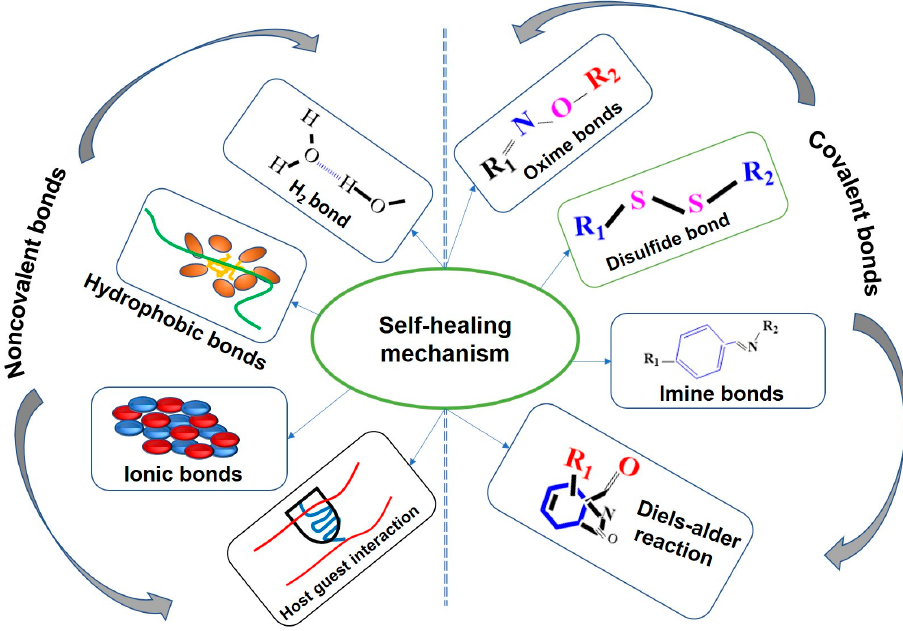
Figure 4. Self-healing mechanisms for hydrogel materials. Re-printed from an open access article under the terms of Creative Commons Attribution 4.0 International License of Ref. [70].